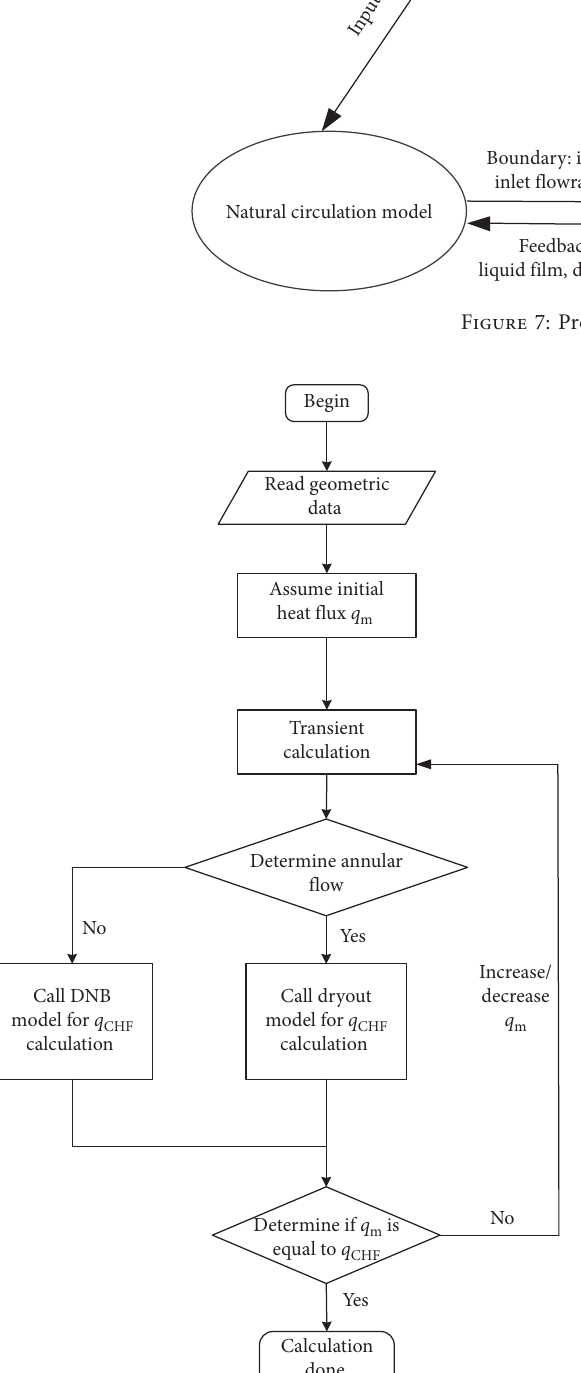
Figure 8: Model coupling